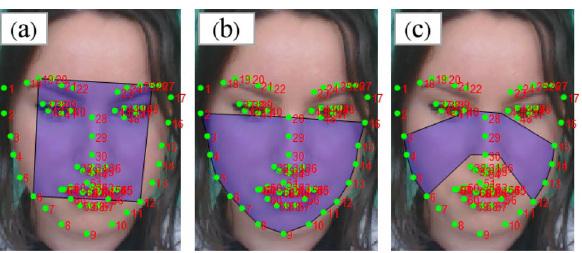
Figure 4. Landmark-based face skin extraction: ( a ) a rectangular face ROI 17 , ( b ) a bottom face ROI 33 , and ( c ) a polygonal face ROI 34